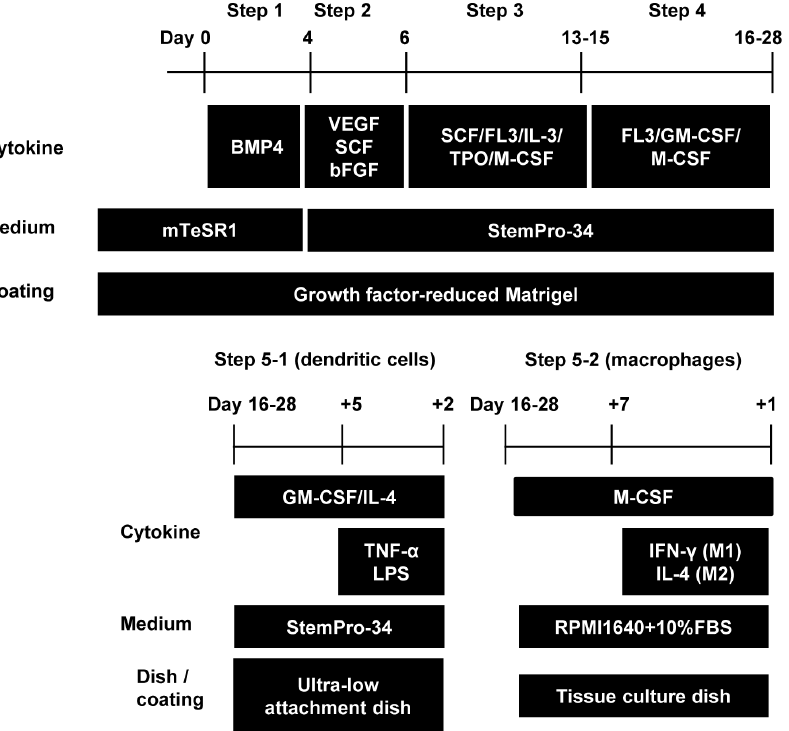
Figure 1. Protocol for monocytic lineage cell differentiation from human pluripotent stem cells. The protocol is composed of 5 steps. CD14-positive cells that are sorted between step-4 are differentiated into dendritic cells by step 5-1 or into macrophages by step 5-2. FL-3: Flt-3 ligand, TPO: Thrombopoietin.